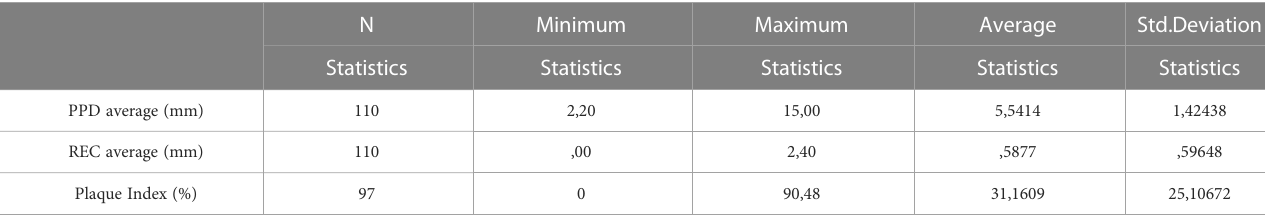
TABLE 5 Average PPD, REC and plaque index in the population.